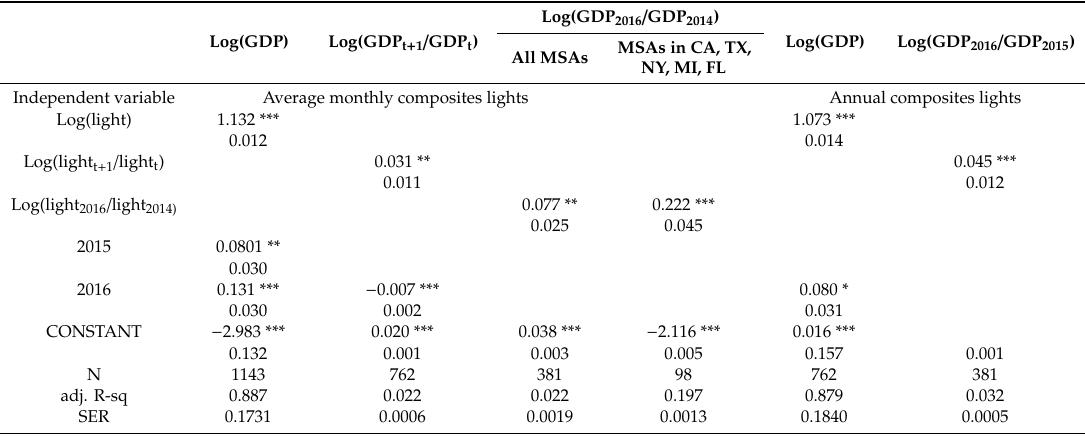
Table 2. Robust regression results for metropolitan level and growth